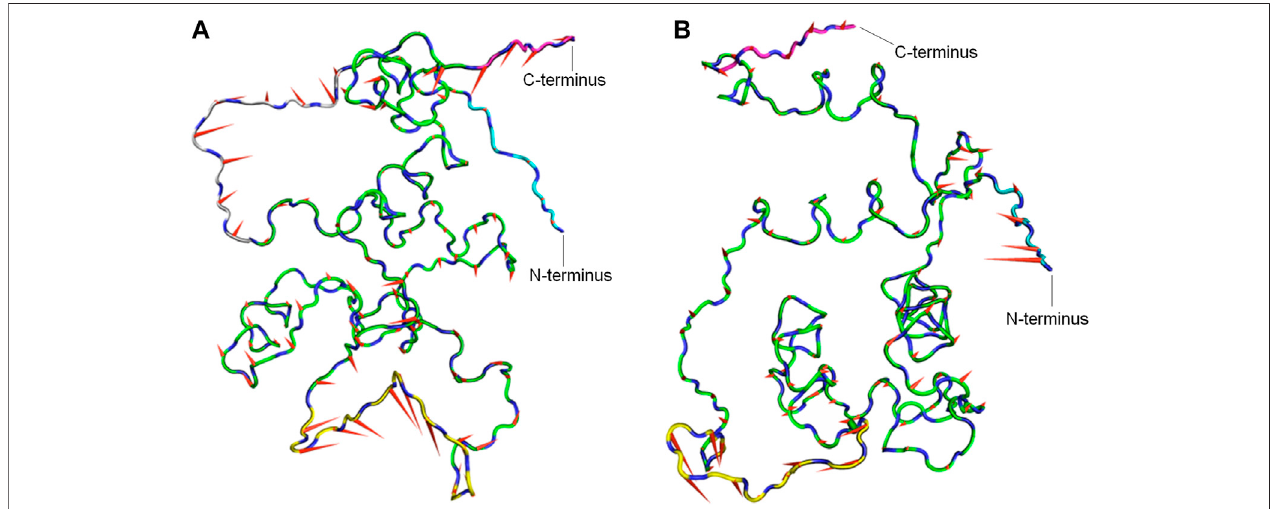
FIGURE6| PorcupineplotsfromPCAanalysisoftheCbtA-modelbackbone. (A) PorcupineplotforPC1. (B) PorcupineplotforPC2.Regionscoloredyellow,gray, cyan,andmagentarepresenttheT75-T84segment,Q10-P16segment,N-terminus,andC-terminus,respectively.Thetipandlengthofeachconeindicatethedirection of the eigenvector and the magnitude of the corresponding value,